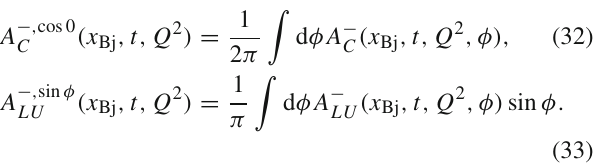
kinematic domain allows to access GPDs, even if | T DVCS | 2 is